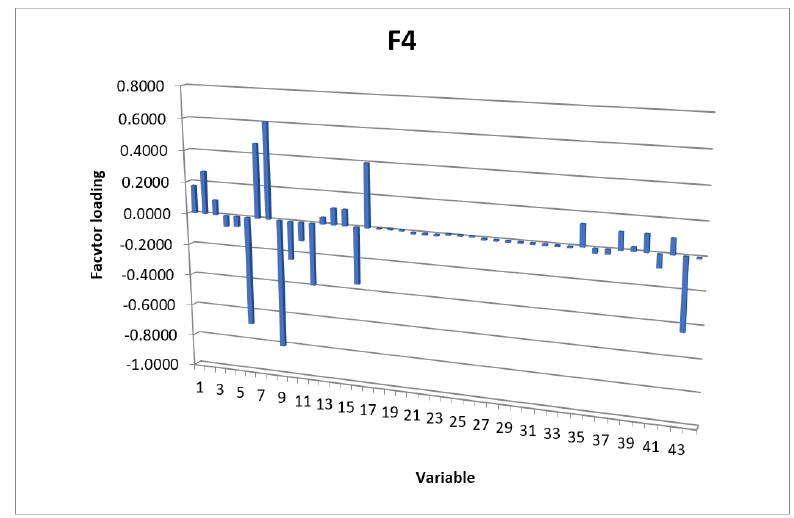
Figure 9. Graphic depiction of factor loads values for input variables for factor F4.